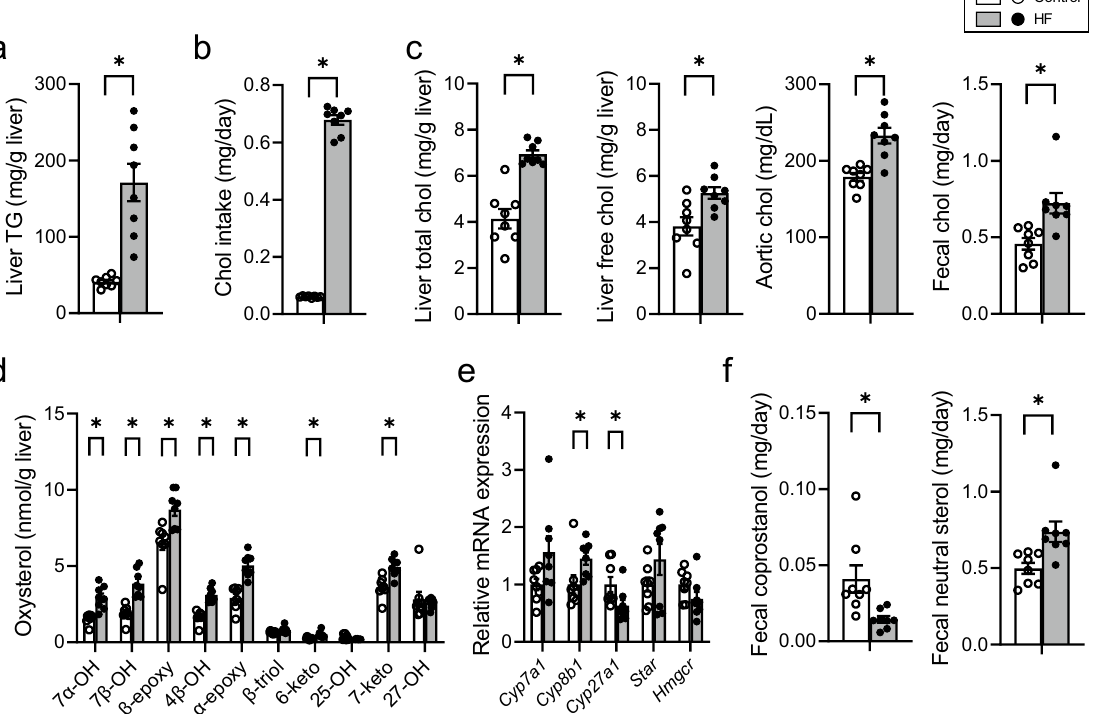
Figure 1. Distribution of chol-related molecules in mice fed control or HF diet. ( a ) Hepatic TG concentration. ( b ) Daily chol intake. ( c ) Chol concentration in the liver, blood, and feces. ( d ) Concentration of liver oxysterols. ( e ) mRNA expression of genes involved in chol metabolism. ( f ) Coprostanol and neutral steroid excretion per day. Open bars, n = 8 for control; filled bars, n = 8 for HF. Data presented in E was normalized to Gapdh mRNA expression. Values are shown as the mean ± SEM (n = 8). Asterisks indicate a significant difference compared with the control ( P <